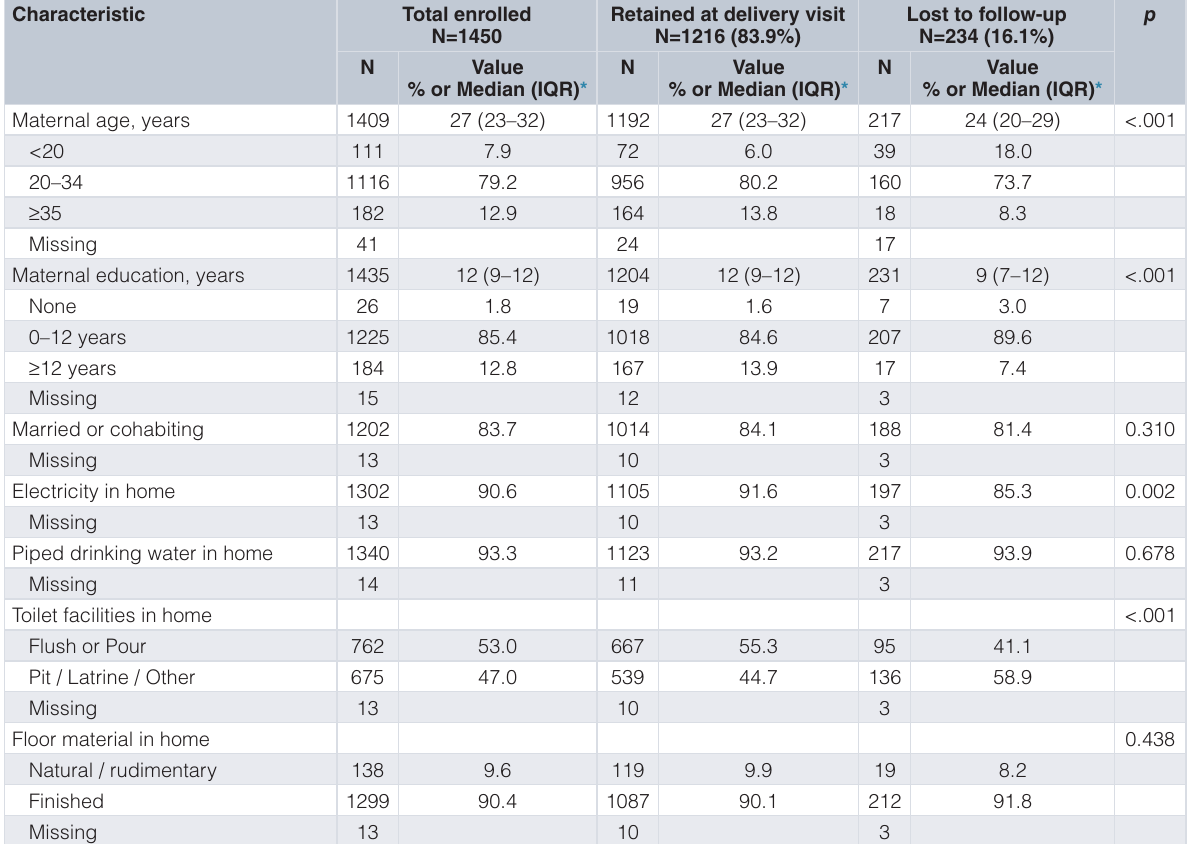
Table 1. Baseline characteristics of ZAPPS cohort,